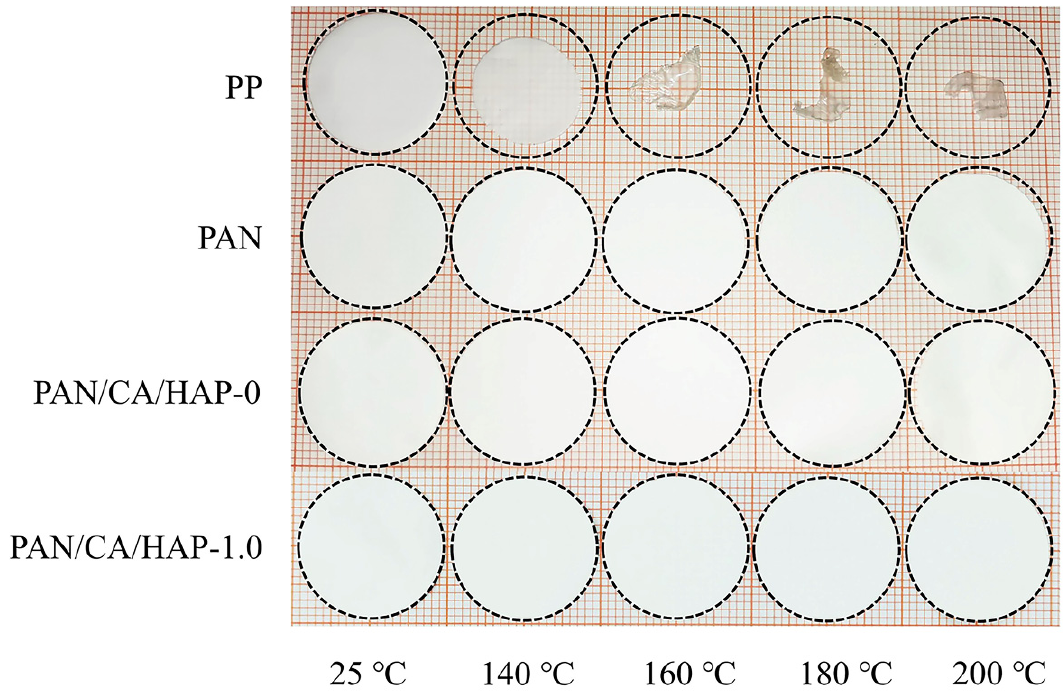
Figure 7. Thermal shrinkage behaviors of the separators after heat treatment at different temperatures for 35 min.